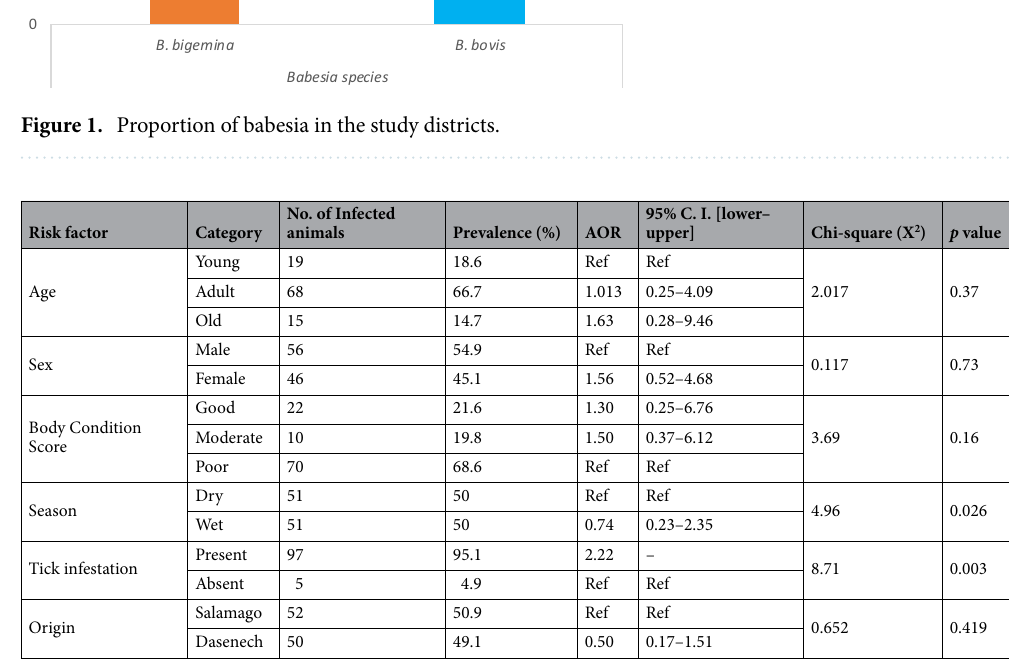
Figure 1. Proportion of babesia in the study districts.